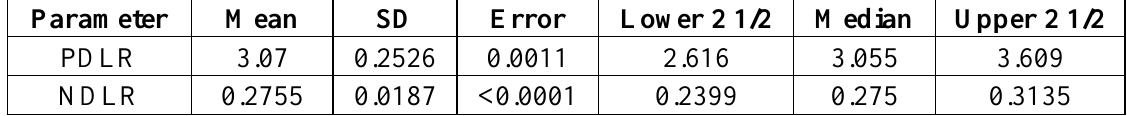
Table 5. Posterior distribution of diagnostic likelihood ratios.